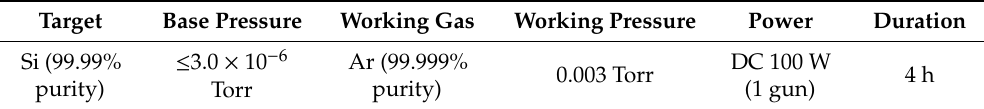
Table 2. Working conditions of magnetron sputtering used in this study. Target Base